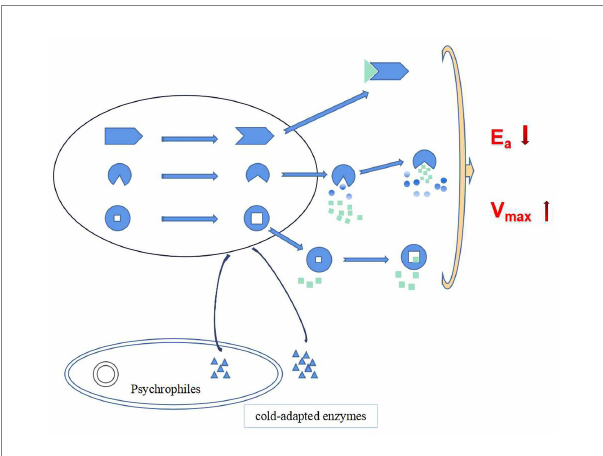
FIGURE 8 Cold catalytic mechanism of cold-adapted enzymes (green square and triangle as substrate molecules, gradient color round as water molecules).